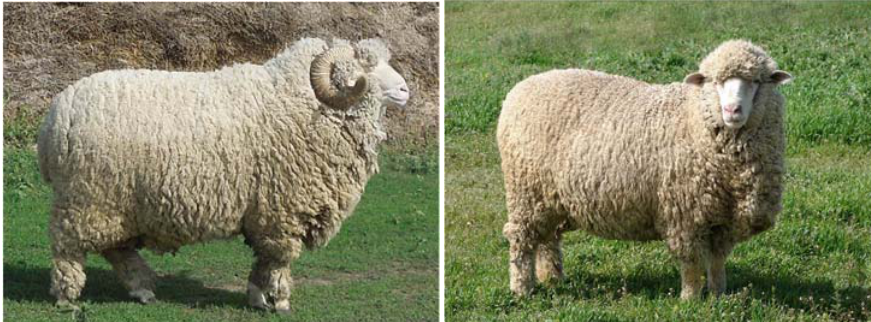
Figure 1. Ram ( left ) and ewe ( right ) of the Jalgin merino.